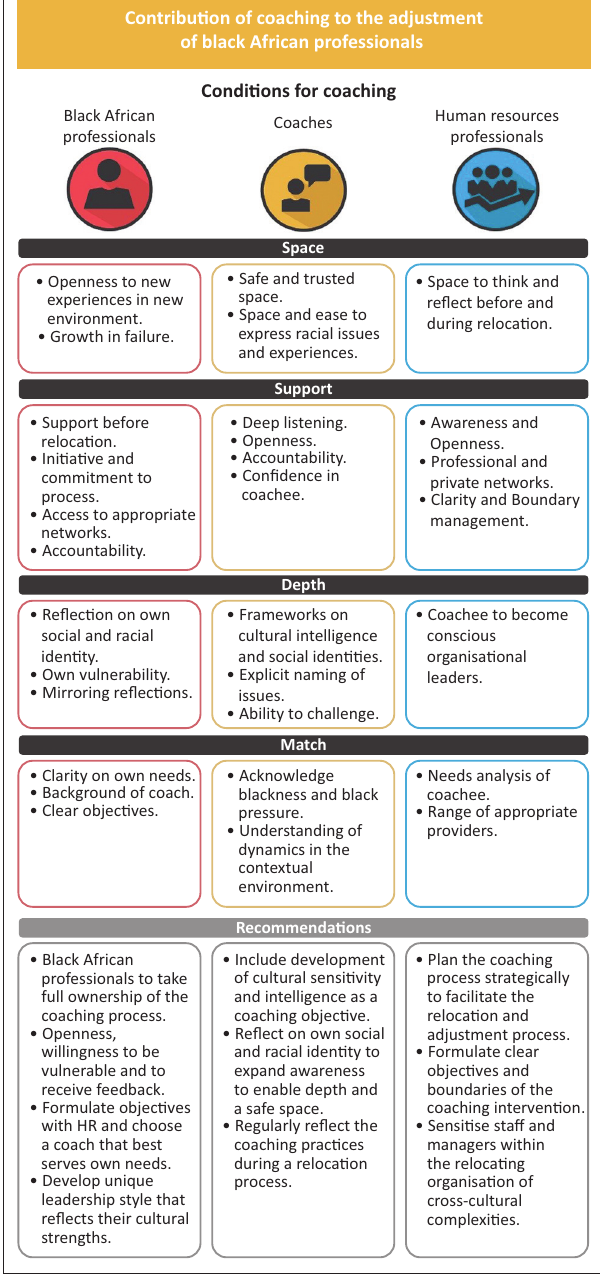
FIGURE 1: Coaching for the adjustment of black African